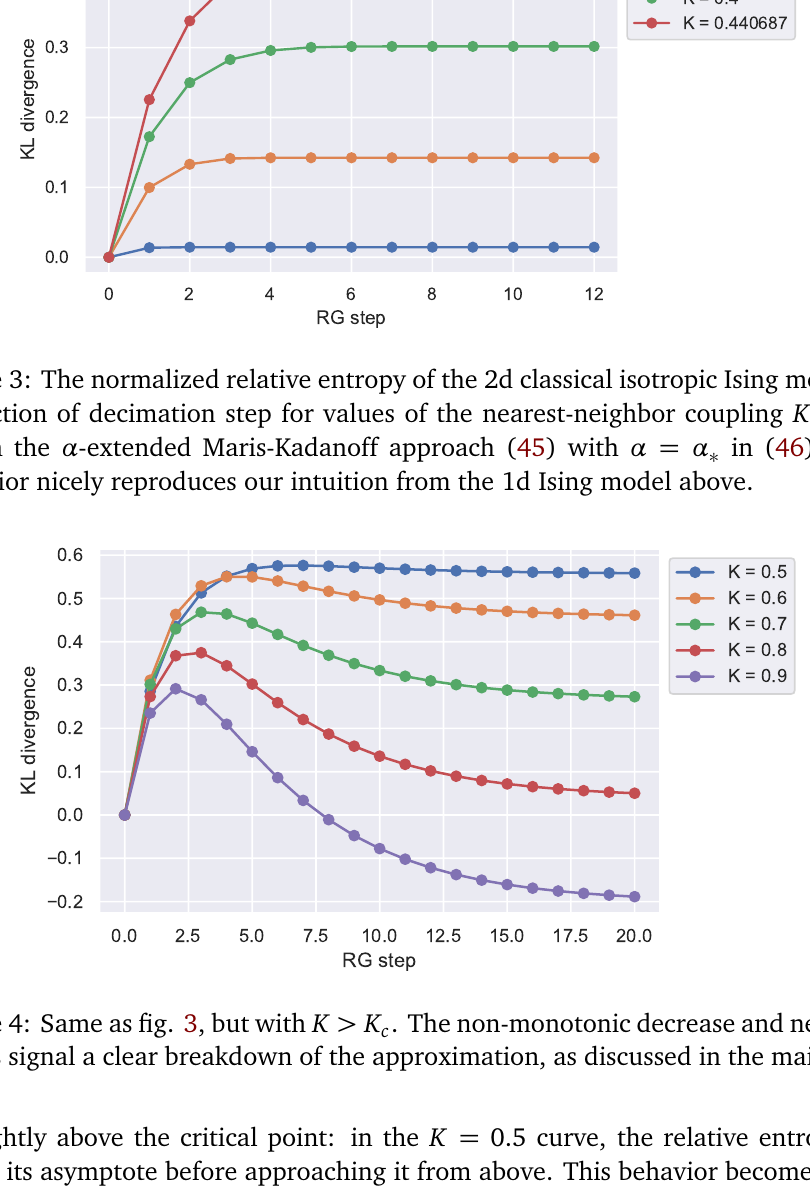
Figure 4: Same as fig. 3, but with K > K . The non-monotonic decrease and negative c values signal a clear breakdown of the approximation, as discussed in the main